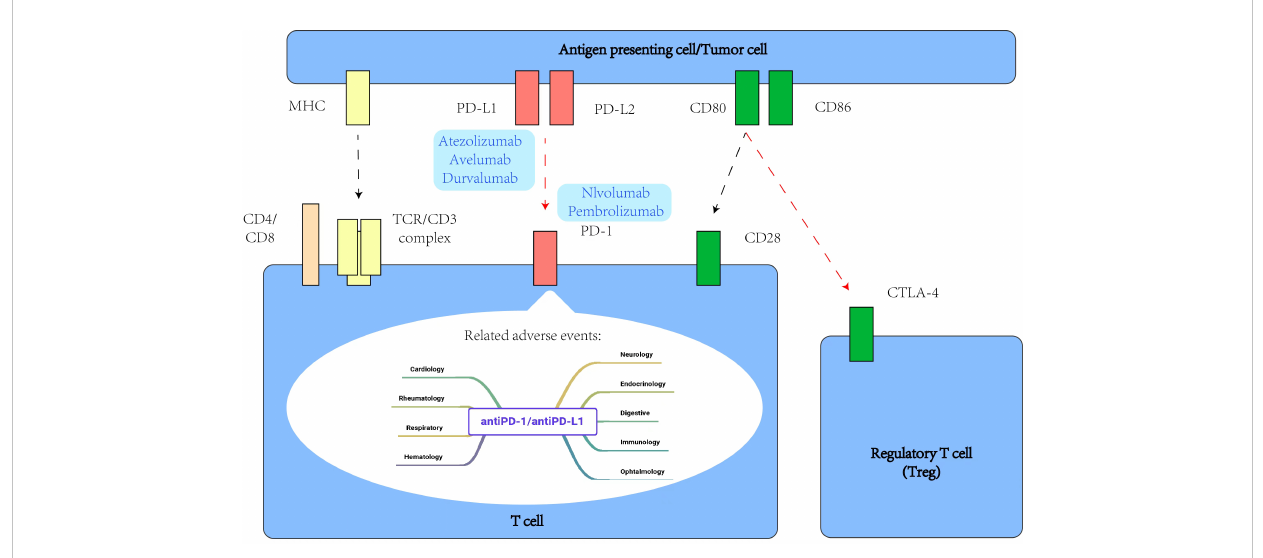
FIGURE 2 Some intracellular signaling events related to PD-1 and CTLA-4 during T cell activation, and main adverse events related to antiPD-1/antiPD-L1